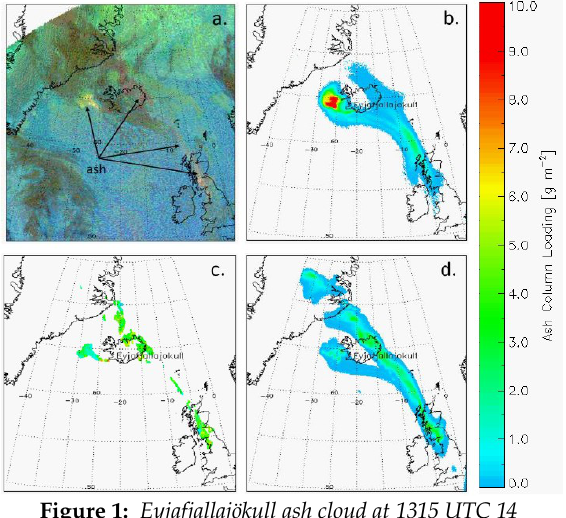
Figure 1: Eyjafjallajökull ash cloud at 1315 UTC